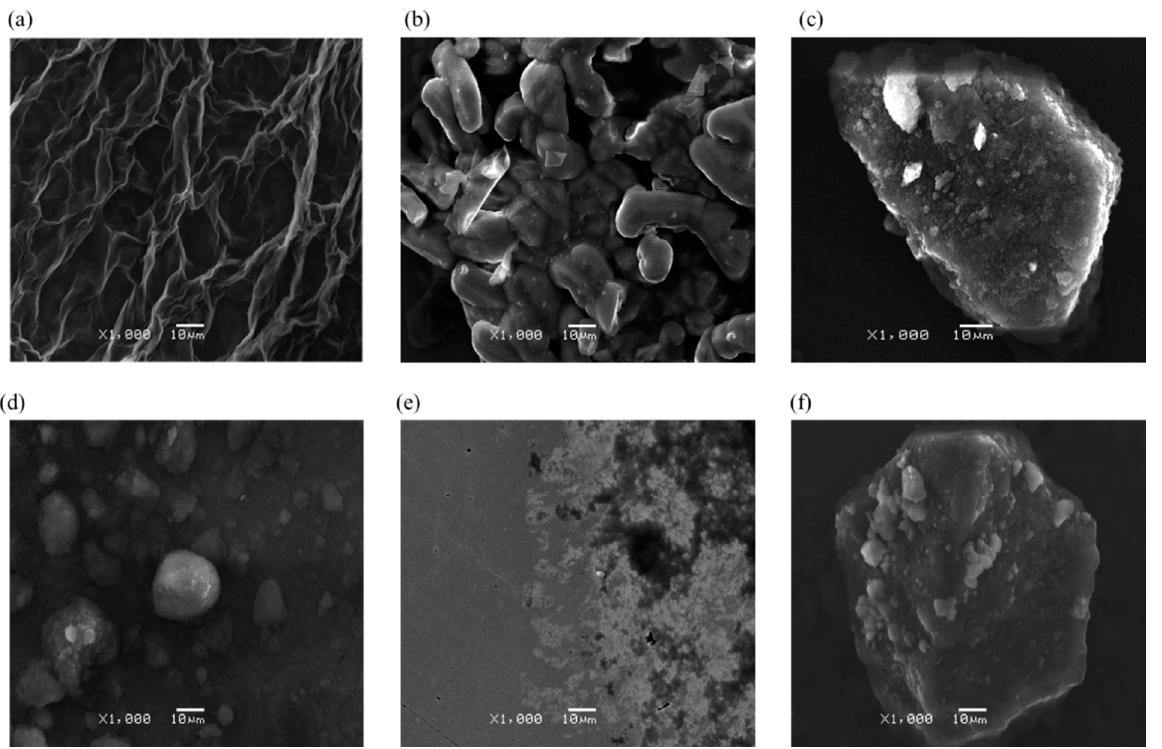
Figure 4. SEM images of the surface morphology Carbon-based Nanomaterials (CBNs): ( a ) graphene oxide (GO) film; ( b ) amorphous carbon powder formed using Radio Frequency Plasma Activated Chemical Vapor Deposition Method); ( c ) fluorescent nanodiamond (MDCHF), ( d ) plasma–chemically modified detonated nanodiamond particles (MDP1); ( e ) chemically modified detonated nanodiamond particles with hydroxyl functional groups (MDCHPOH); ( f ) pure detonated nanodiamond particles (DND).